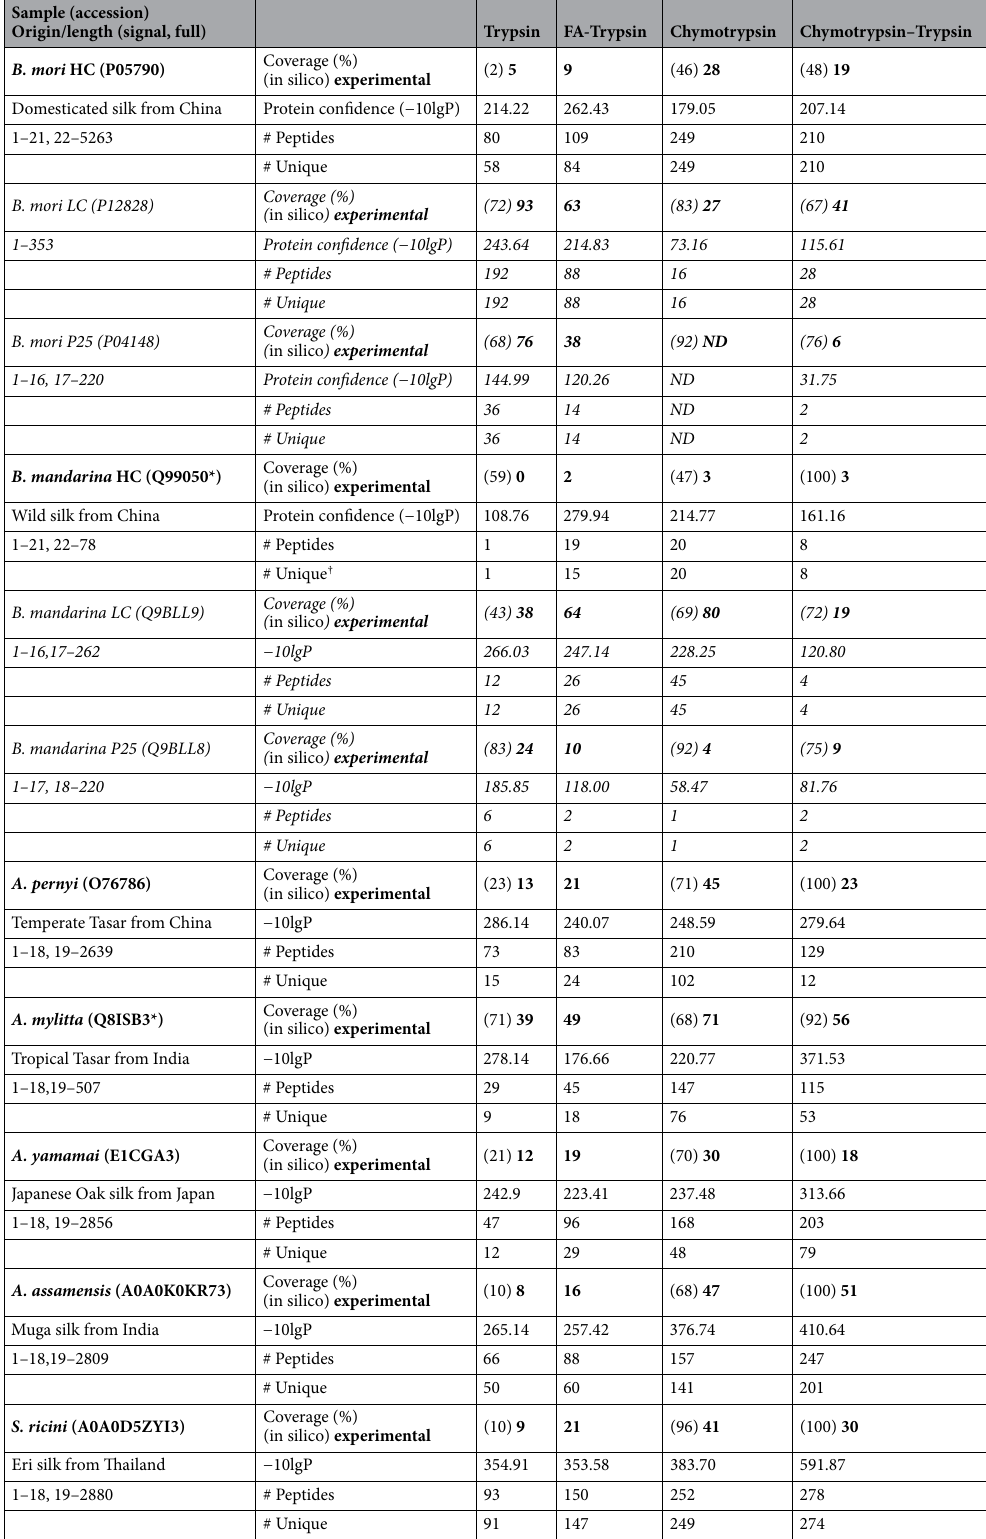
Table 1. Summary of peptide analysis metrics for protein identification in each of the modern silk samples solubilised and digested with different proteases. Experimental coverage values are in bold. Accession codes are in the format of UniProtKB. The false discovery rate (FDR) for peptide probability is ≤ 1%. N/A not available, ND not detected. The light chain (LC) and P25 proteins of Bombyx fibroins are displayed in italics font. *Reference sequences for B. mandarina HC and A. mylitta HC are incomplete. † All B. mandarina HC peptides only matched to the B. mori reference